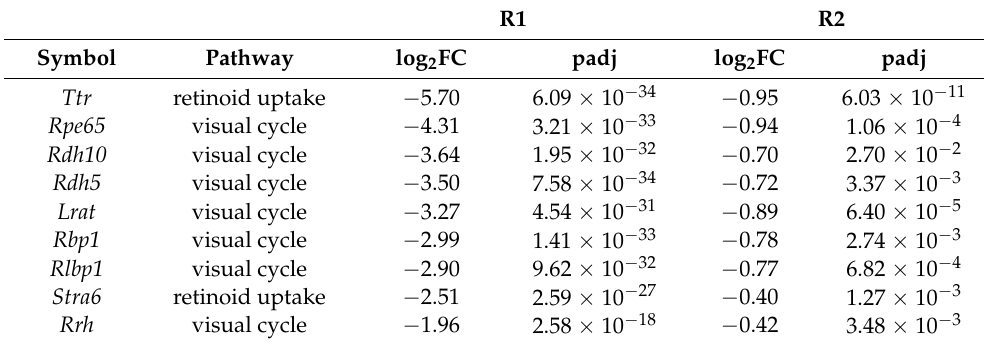
Table 4. Differential expression of selected visual cycle and retinoid uptake genes in cluster C1.